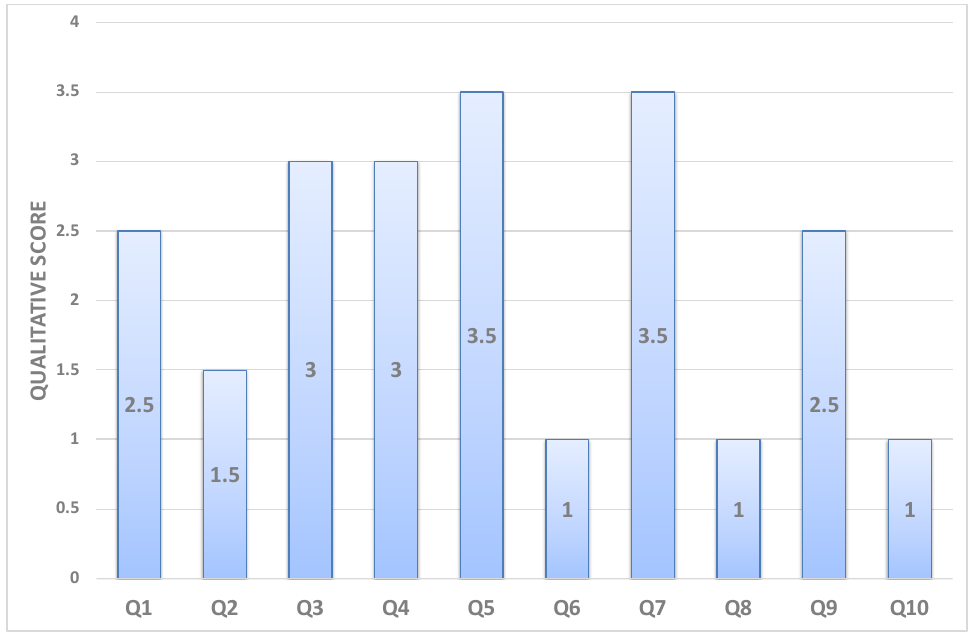
Figure 20. Average of patient feedback based on System Usability Scale Questionnaire (SUS) criteria.